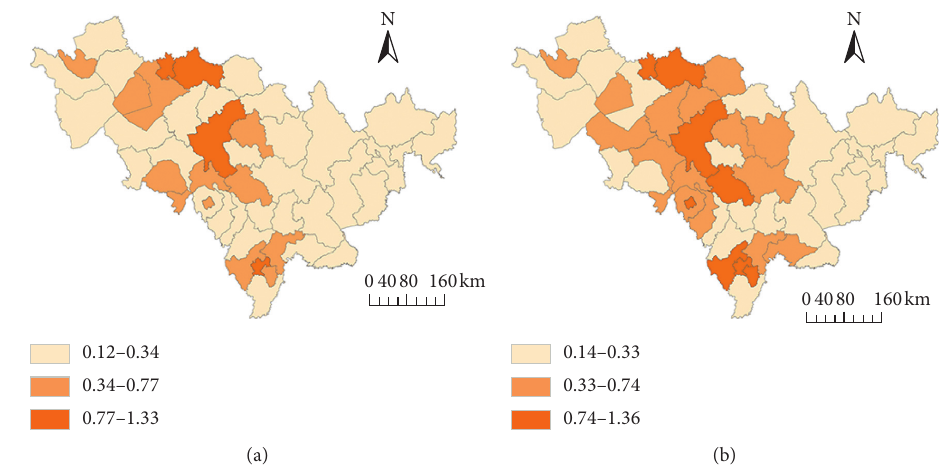
Figure 3: Spatial-temporal pattern of green utilization efficiency of urban construction land in different time periods: (a) 2011 and (b) 2015.